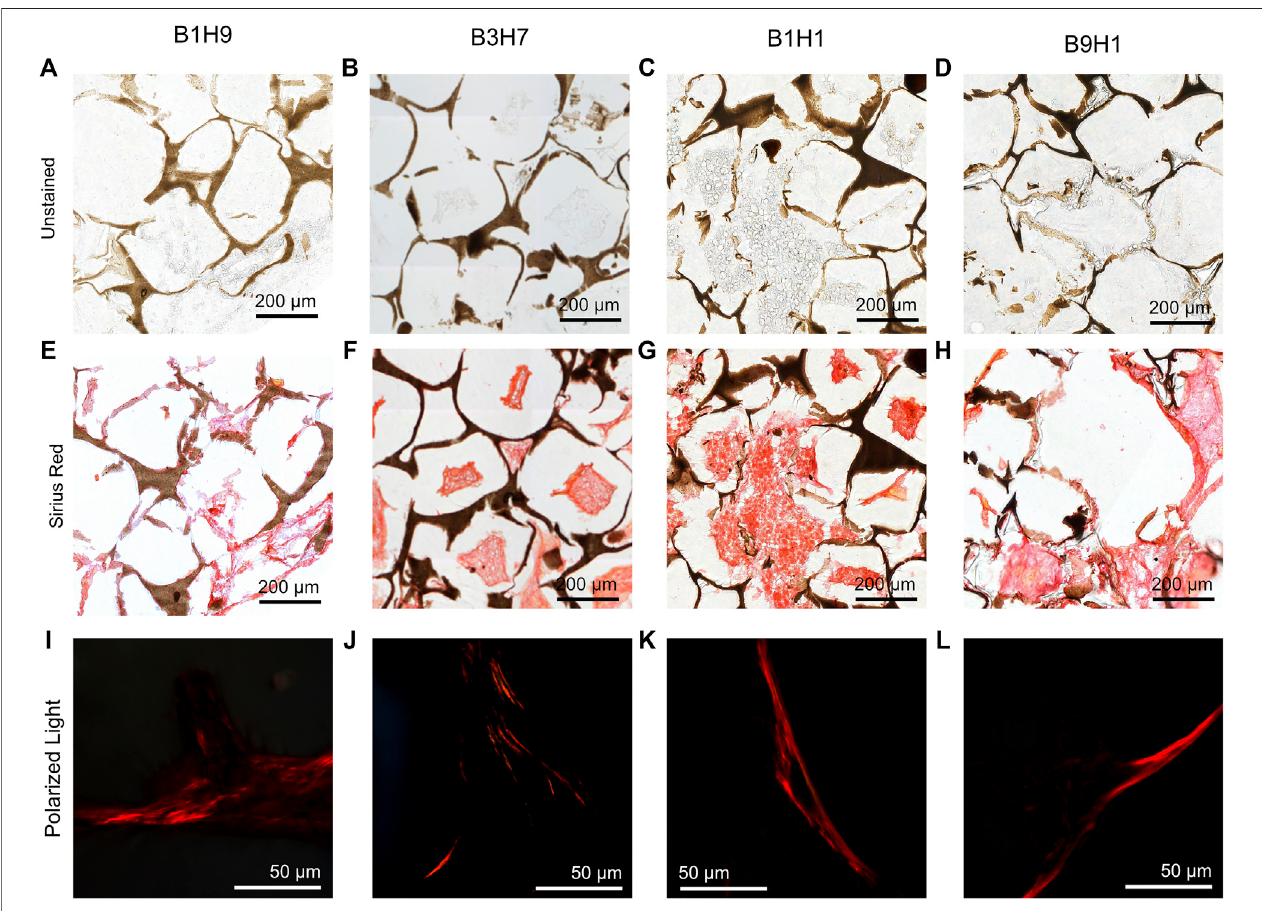
FIGURE 3 | Collagenous extracellular matrix formation. (A) Microscopy images of unstained B1H9, (B) of B3H7, (C) of B1H1, and (D) of B9H1 nanocomposite scaffolds; (E-H) the same samples stained with Picro Sirius Red. (I-L) Representative polarized light microscopy images of birefringent collagen fi bers in the nanocomposite scaffolds. Horizontal scaffold sections were taken from the top 300 µm of the scaffolds. N = 2 samples were sectioned for each